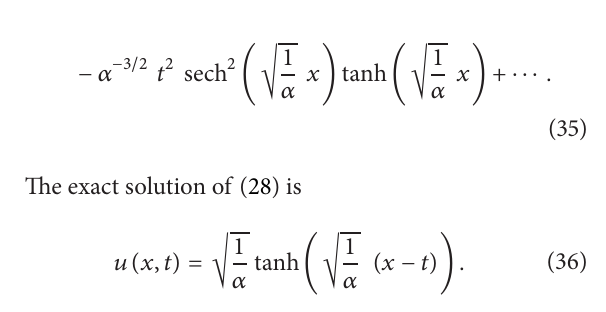
(𝑥, 𝑡) is shown in 4.1. 𝛼=1 . The behavior of 𝑢(𝑥, 𝑡) and 𝑢 app Figure 4 for the regions −10 ≤ 𝑥 ≤ 10 and 0 ≤ 𝑡 ≤ 0.3 . Absolute errors for differences between the exact solution and the 8th order approximate solution given by HPM for 𝛼 =